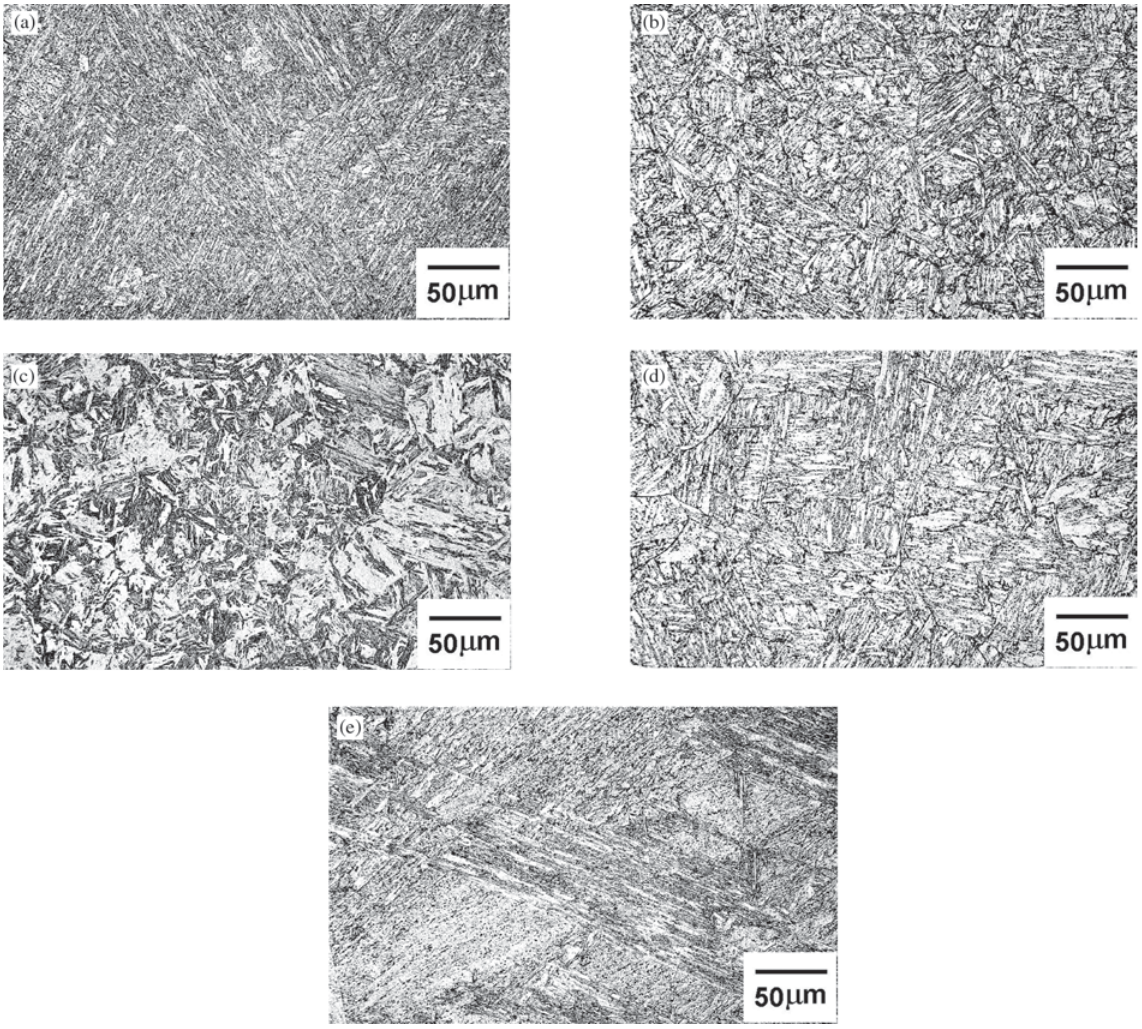
Figure 2. Microstructures obtained from quenching and tempering (Q&T) the A508 steel: a) I , b) J ; c) K , d) L and e) M . Etched in Nital